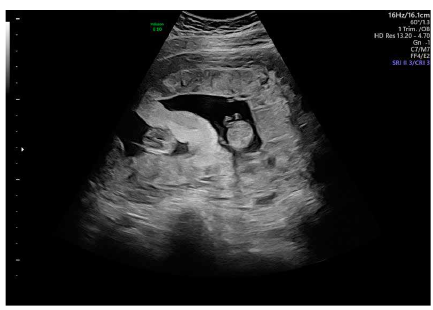
Figure 2: Patient at 11 + 0 weeks EGA with intertwin membrane hemorrhage, 15 mm in thickness.